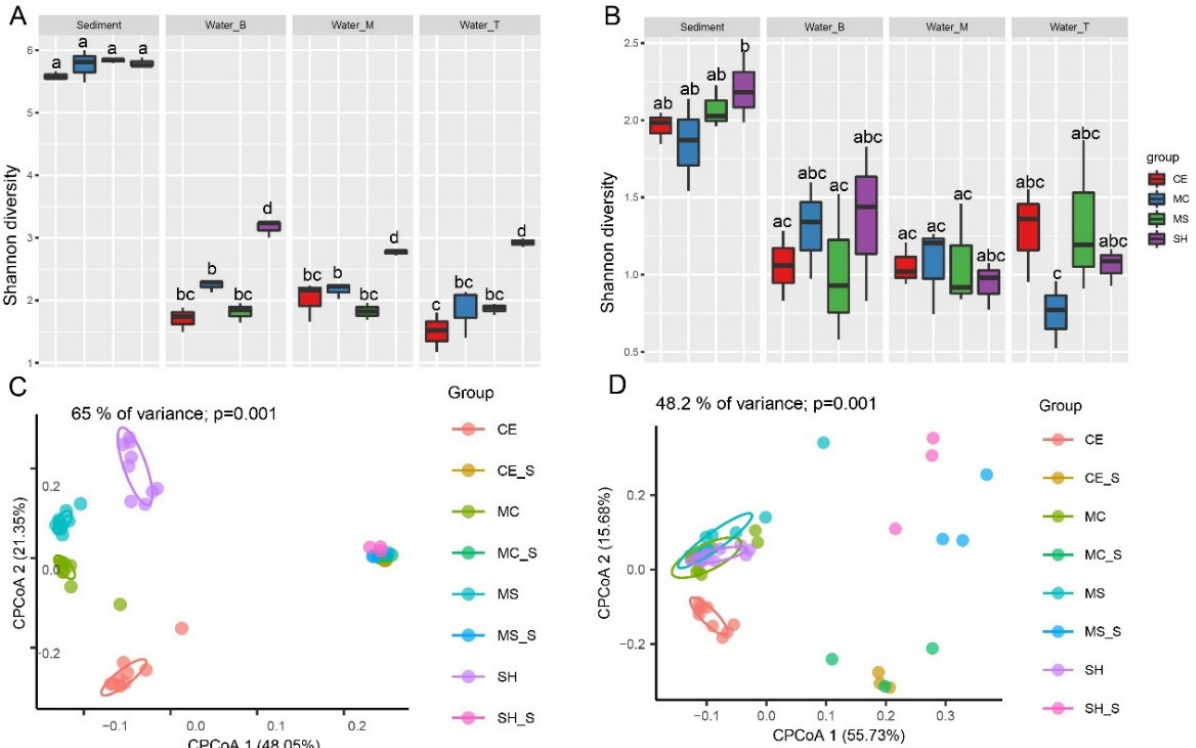
Figure 2. Bacterial and archaeal diversity of water and sediment at different sampling points. ( A ) Bacteria Shannon index in different points; ( B ) Archaea Shannon index in different points; ( C ) Bacterial CPCoA plot using Bray–Curtis dissimilarity based on OTUs in different points ( D ) Archaeal diversity CPCoA plot using Bray–Curtis dissimilarity based on OTUs in different points. Four sampling points: SH (SH in water), SH_S (SH in sediment), MS (MS in water), MS_S (MS in sediment), MC (MC in water), MC_S (MC in sediment), CE (CE in water), and CE_S (CE in sediment).